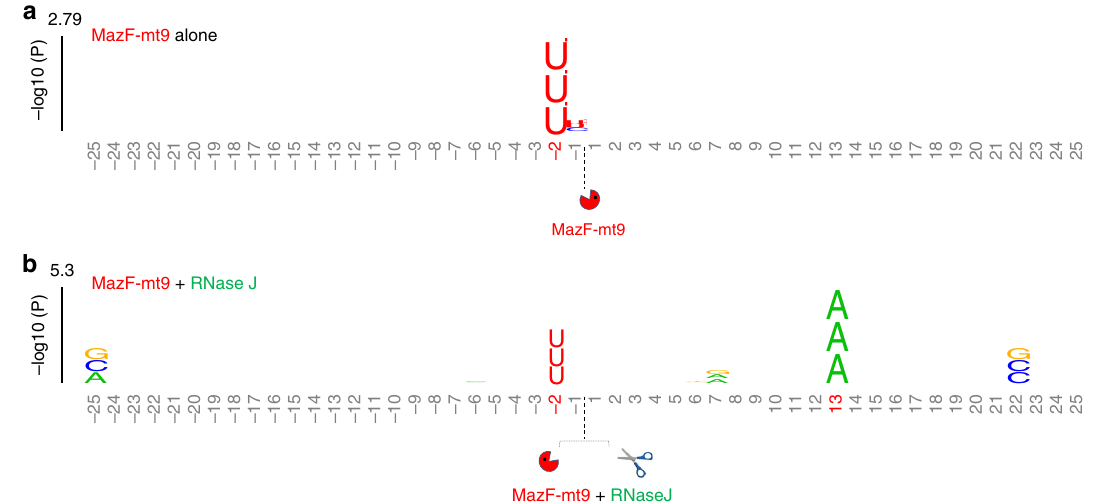
Fig. 5 M. tuberculosis RNase J cleaves 5 ′ of stalled ribosomes favoring expression of AAA-de fi cient transcripts. KpLogo 38 graphs derived from E. coli 5 ′ RNA-seq + MazF-mt9 ( a ) or + MazF-mt9 + RNase J ( b ) datasets compared to -MazF-mt9 samples. The enriched k-mers in the datasets are stacked vertically at the position of their initial nucleotide. The positions are numbered relative to the cleavage site (dotted line), with those achieving statistical signi fi cance (Bonferroni corrected p -value < 0.01) shown in red Fig. 4). Comparison of ±MazF-mt9 samples revealed similar protein levels and band patterns (Supplementary Fig. 4).